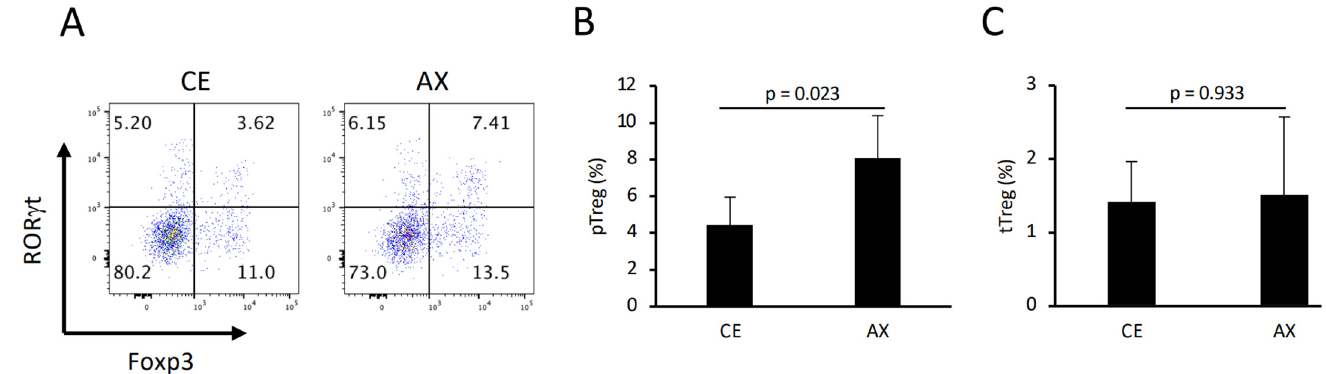
Figure 4. The percentage of colonic pTreg and thymus-derived Treg (tTreg) cells in mice fed CE or AX: ( A ) Typical FACS panel showing Foxp3 and ROR γ t expression in colonic CD4 + T cells. ( B , C ) Percentage of pTreg and tTreg cells, defined as Foxp3 + ROR γ t + Helios - or Foxp3 + ROR γ t - Helios + cells, respectively. (n = 6). Values and error bars indicate the mean ± SD.